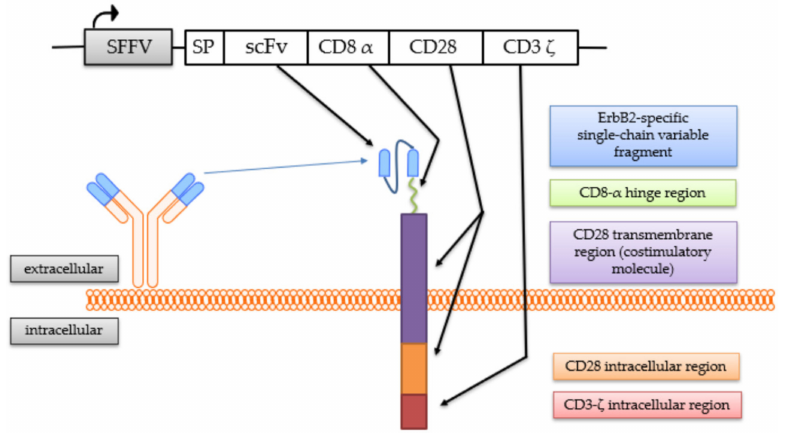
Figure 1. Chimeric antigen receptor (CAR) expressed by NK-92/5.28.z cells. The coding regions of the lentiviral CAR vector and the CAR molecule with its protein domains are schematically